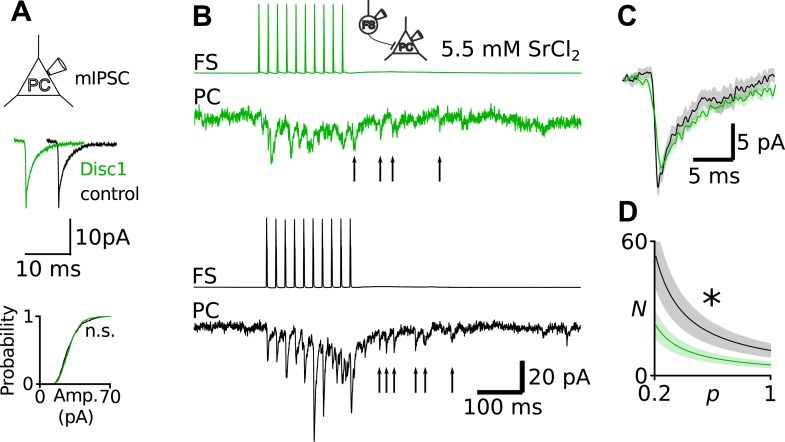
Unaltered Q at Disc1 FS-IN-to-PC synapses.(A) Recordings of mIPSCs in PCs revealed identical amplitudes in Disc1 and control cells (N = 24, 15, p = 0.388). (B) Direct recording of quantal uIPSCs at FS-IN-to-PC synapses revealed identical Q. Quantal release was evoked in pairs in an extracellular medium containing SrCl2. Quantal uIPSCs are visible as asynchronous events following a presynaptic action potential train. (C) Superimposed average quantal uIPSCs. (D) Simulation of apparent N as a function of p. As a result of the quantification of Q shown in B and C, Q was set to 11 pA in these calculations. Independent of the value of p, N at Disc1 FS-IN output synapses is always smaller than at control pairs. *p < 0.05.